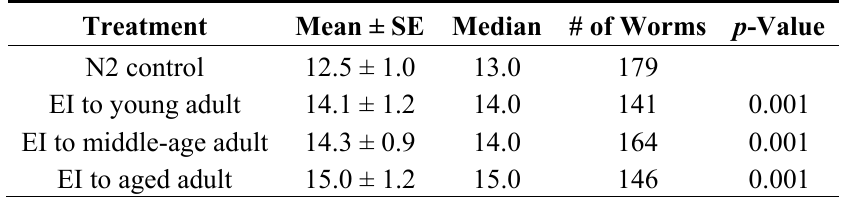
Table 2. The lifespan of worms at 25 °C with various early-start interventions. Lifespan and standard error are shown in